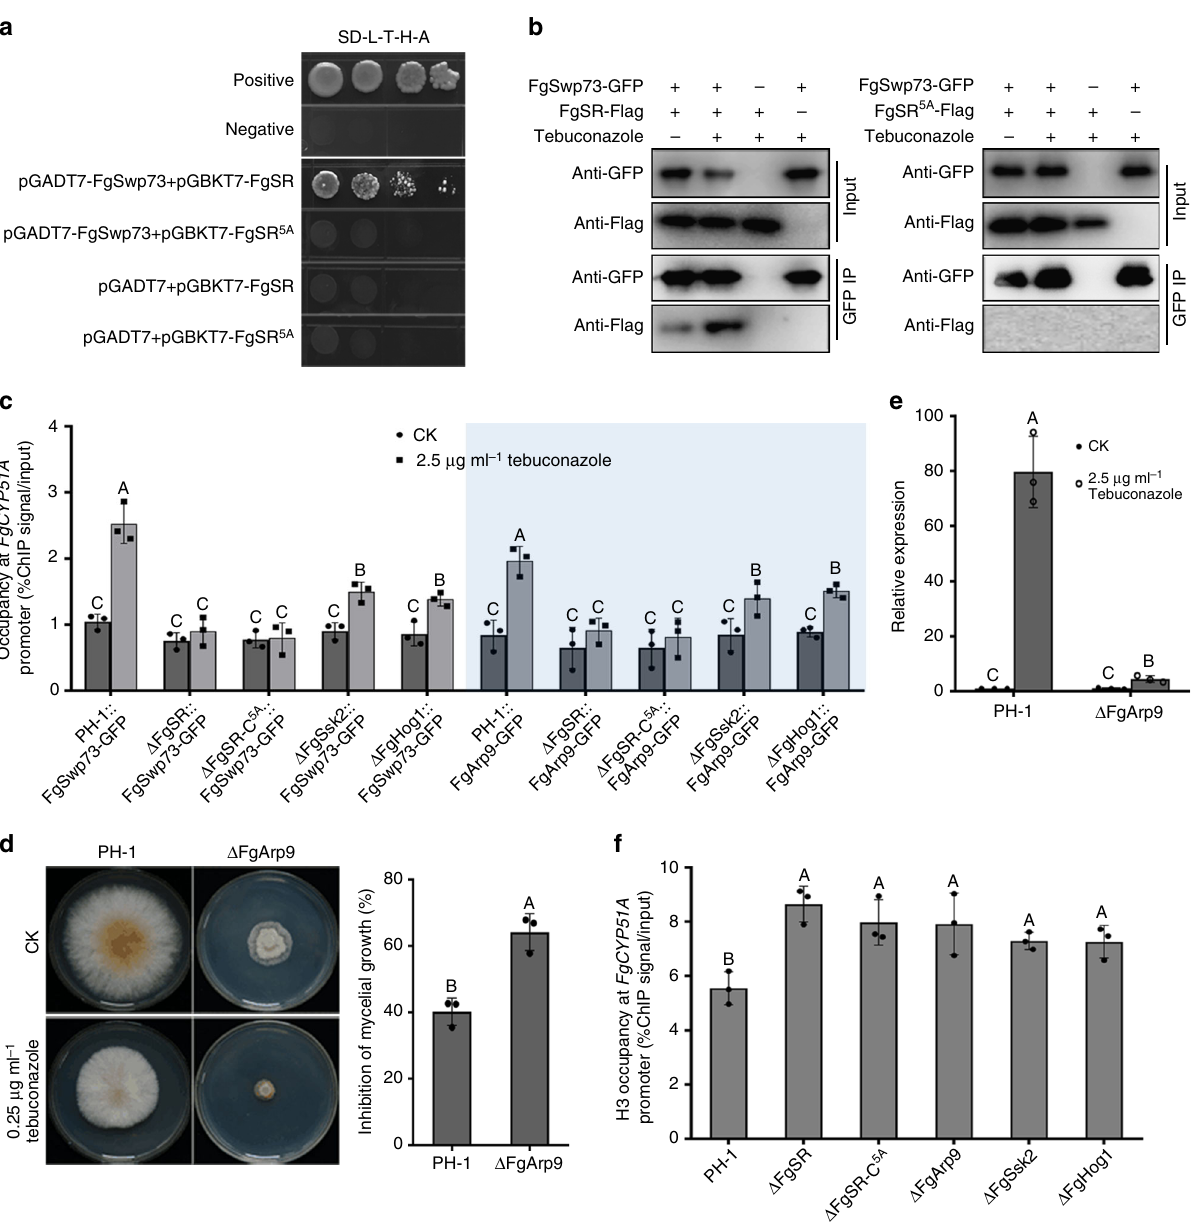
Fig. 4 Phosphorylated FgSR interacts with the SWI/SNF complex to regulate transcription of FgCYP51A . a The yeast two-hybrid (Y2H) assay revealed that the 5 phosphorylation residues of FgSR are critical for its interaction with FgSwp73. b FgSR interacts with FgSwp73 in the co-immunoprecipitation (Co-IP) assay. The relative strains were treated with or without tebuconazole for 2 h after incubated in YEPD for 36 h. c The enrichment of FgSwp73-GFP and FgArp9-GFP at the FgCYP51A promoter among the wild-type PH-1, Δ FgSR, Δ FgSsk2, Δ FgHog1, and Δ FgSR-C 5A . ChIP- and input-DNA samples were quanti fi ed by quantitative PCR assays with the primer pair A2 indicated in Fig. 2b, and rabbit IgG was used as a control. d Deletion of the SWI/SNF complex subunit FgARP9 led to increased sensitivity to tebuconazole. A 5-mm mycelial plug of PH-1, Δ FgArp9 was inoculated on PDA alone or supplemented with 0.25 μ g ml – 1 tebuconazole (left panel), and the mycelial growth inhibition was calculated for each strain (right panel). e Comparisons of the expression of FgCYP51A between PH-1 and Δ FgArp9 after the treatment with 2.5 μ g ml – 1 tebuconazole for 6 h. The expression of FgCYP51A in the wild type without treatment was referred to 1. f The enrichment of histone H3 at the FgCYP51A promoter among the above strains. ChIP- and input-DNA samples were quanti fi ed by quantitative PCR assays with the primer pair A2 indicated in Fig. 2b, and rabbit IgG was used as a control. Data presented are the mean ± s.d. ( n = 3). Bars followed by the same letter are not signi fi cantly different according to a LSD test at P =